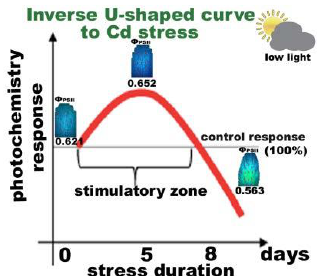
Figure 14. Overview of the hormetic response of photosystem II photochemistry to Cd exposure. Hormesis [96] is defined as the stimulatory effect of short exposure times of toxic constituents, e.g., Cd on a biological factor (photosystem II photochemistry), of a particular organism ( S. sclarea ). The hormetic effect is defined by an inverse U-shaped biphasic curve [8,34] in which short exposure time has a stimulatory effect; however, at longer exposure time, a toxic effect is